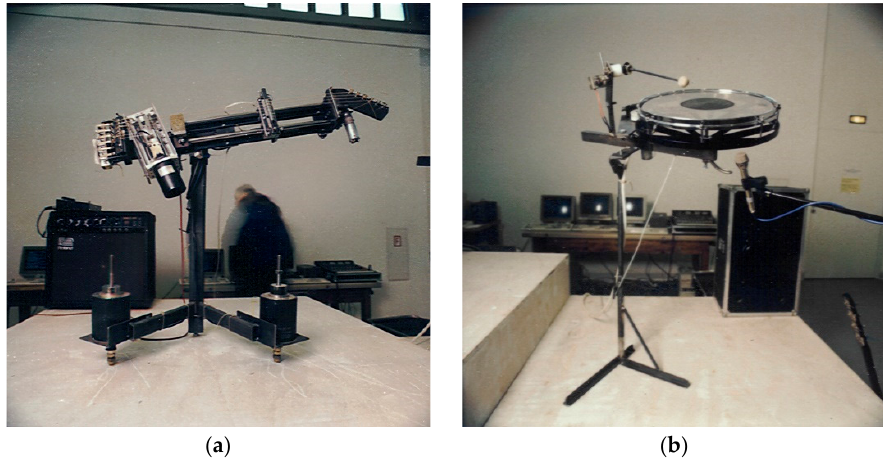
Figure 1. ( a ) The robot guitar Aglaopheme and ( b ) the robot drum Thelxiepeia preparing for the Mediale (Hamburg) in 1993. Courtesy of Nicolas Baginsky.